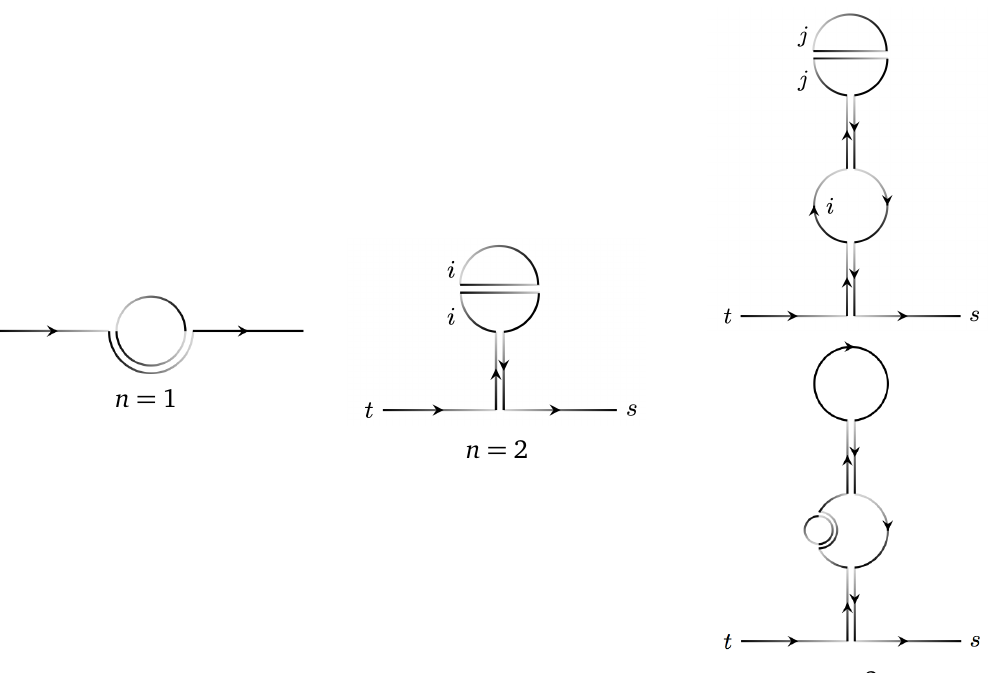
Figure 2: The subleading correction to the MFT result is due to an infinite series of O ( T / N ) mushroom diagrams. For linear models, the 1PI diagrams take the form shown here. Note that we also have a second, virtually identical series with the opposite orientation for the uppermost horizontal double-bar, or (in the case of the bottom right diagram) the nested loop on the opposite side. Relative to the O ( 1 )